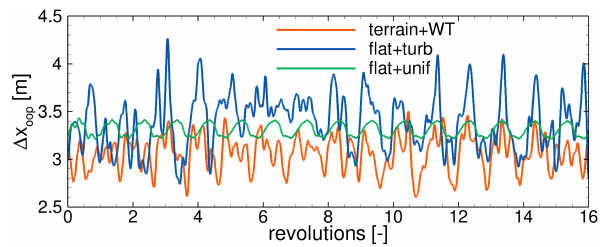
Figure 11. Deformation of blade tip out of the rotor plane (cid:49)x oop for all